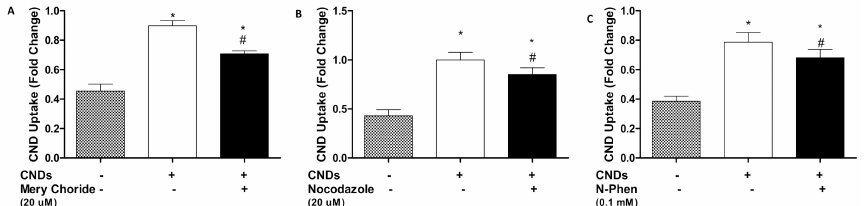
Figure 7. Effect of mercury chloride ( A ), nocodazole ( B ) and N-phen ( C ) on the uptake of CNDs into macrophages. THP-1 human monocyte-derived macrophages were treated for 30 min with or without inhibitors (for 15 min). Next, cells were treated with 0.1 mg/mL CNDs for 24 h. Lastly, cells were harvested and placed in a 96-well plate. Fluorescence analysis ensued in a BioTek™ Synergy 2.0 plate reader. All data represent mean ± SEM. ( n = 4, *, p < 0.05 vs. control, #, p < 0.05 vs. CND treatment only).